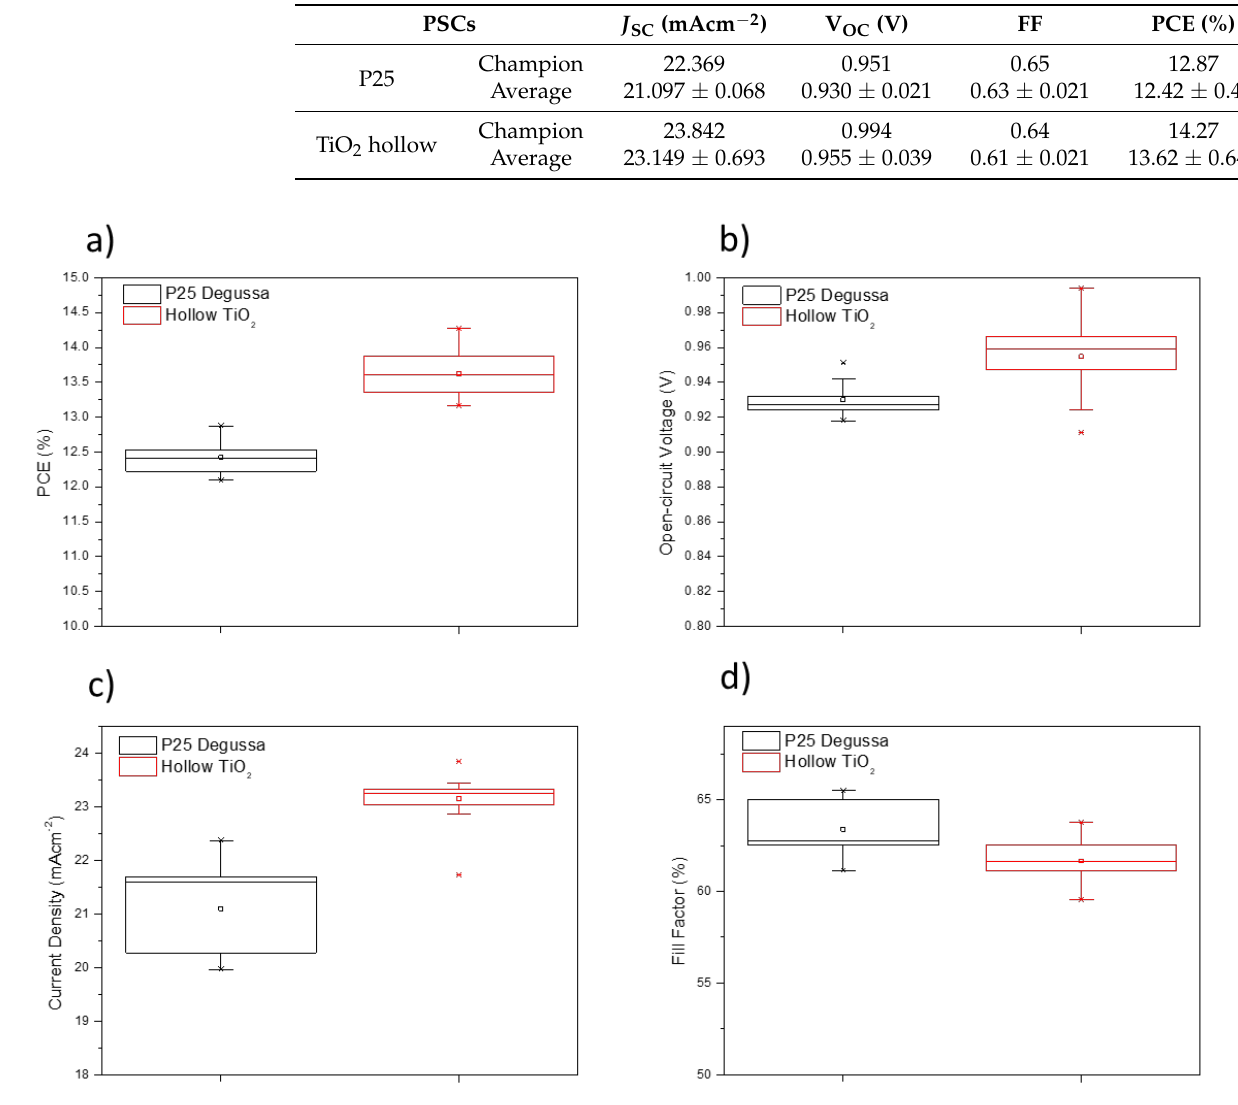
Table 2. The photovoltaic performances of the PSCs under sunlight illumination of 100 mWcm − 2 (AM 1.5 G). The results are based on the average values of 36 cells.